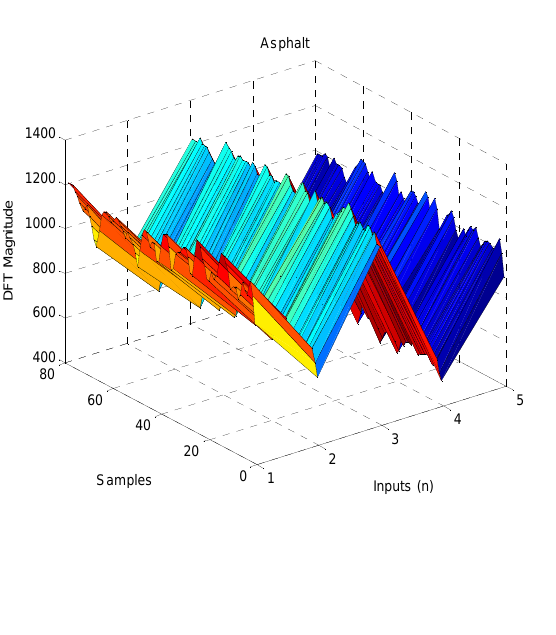
Figure 6. Preprocessed input data for terrain